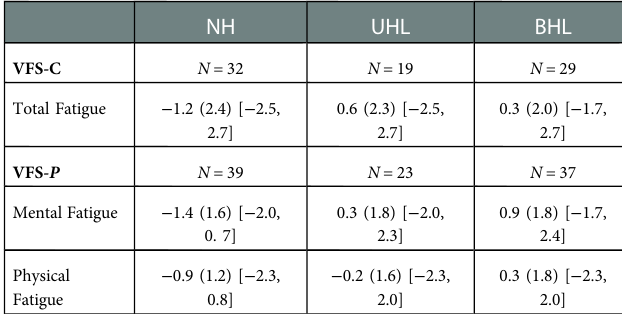
TABLE 3 Medians (interquartile range) and [min, max] of child self-report and parent-proxy report scores from the